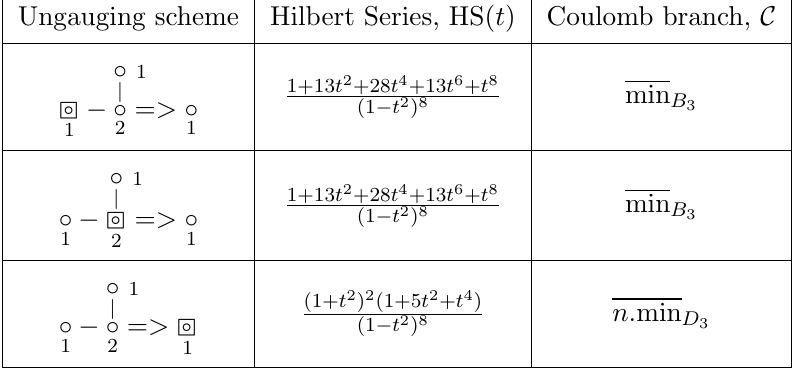
Table 3 . Di(cid:11)erent ungauging schemes for the a(cid:14)ne B 3 quiver. collected in table 3. The Coulomb branches in the (cid:12)rst two rows of table 3 correspond to the closure of the minimal nilpotent orbit of so (7) and the highest weight generating function is given by